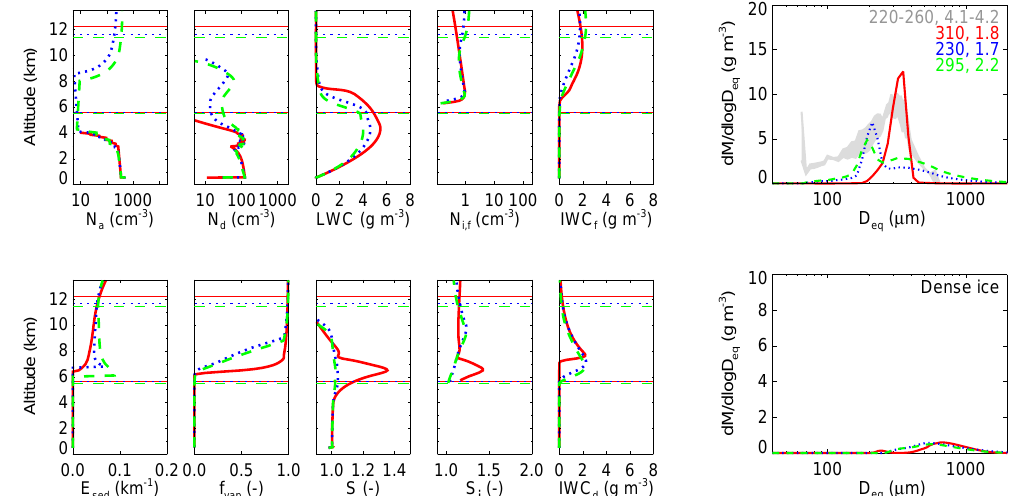
Figure 15. Processes and panels as in Fig. 12, except first panel is profile of total aerosol number concentration ( N a ), for simulations with baseline updraft (red solid line) and additionally entraining environmental air from the steady-state column simulation with entrainment rates of 0.1 (blue dotted line) and 0.2km − 1 (green dashed line). Details provided in